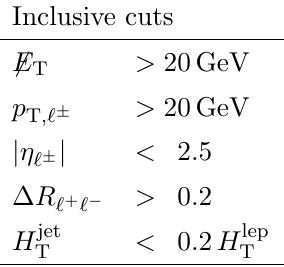
Table 2 . Inclusive selection cuts for o(cid:11)-shell vector-boson pair production in the 2 ‘ 2 (cid:23) channel. The missing transverse momentum E T is calculated from the vector sum of neutrino momenta. 6 evaluated at the central scale. This is justi(cid:12)ed by the fact that (cid:14) EW ( (cid:22) R ; (cid:22) F ) is independent of (cid:22) R and involves only a very weak (cid:22) F dependence of ( (cid:11) ), while the LO QCD (cid:22) F - O dependence cancels out in the